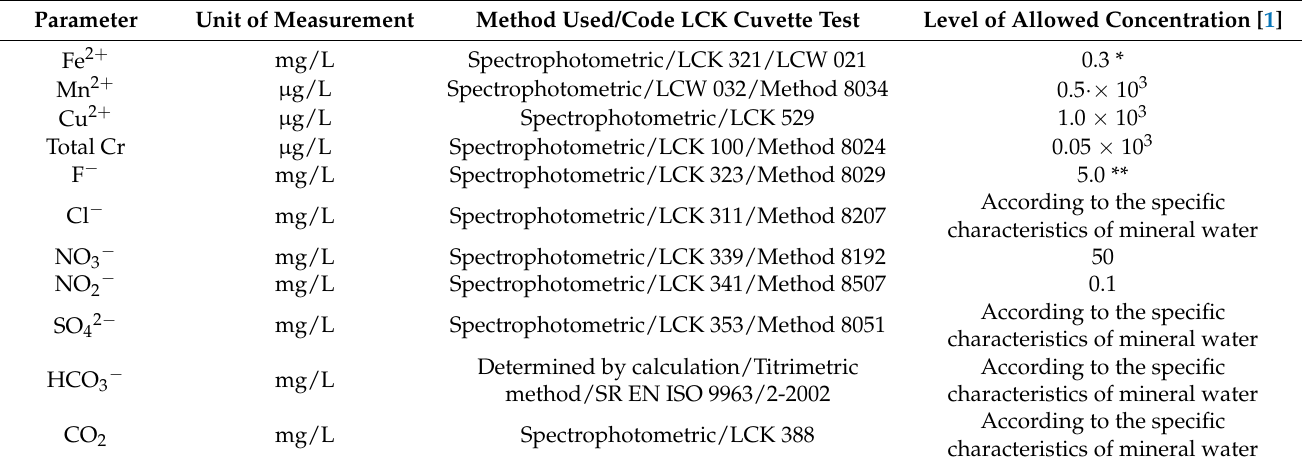
Table 1. Methods used for UV-Vis determination of chemical